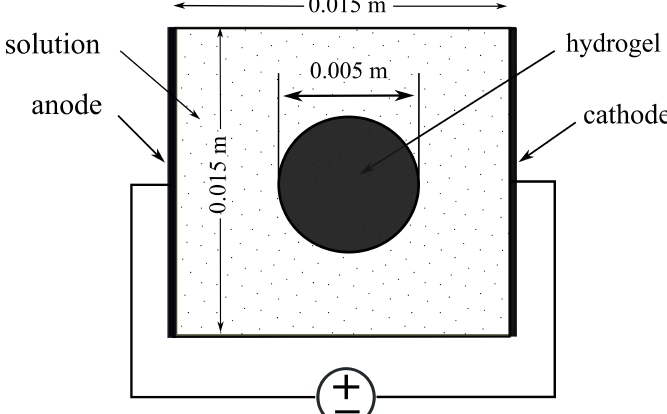
Figure 1. Various steps involved in tissue engineering of knee articular cartilage using electrical stimulation by replacing defect site with chondrocyte-seeded hydrogel (adapted from [11]).